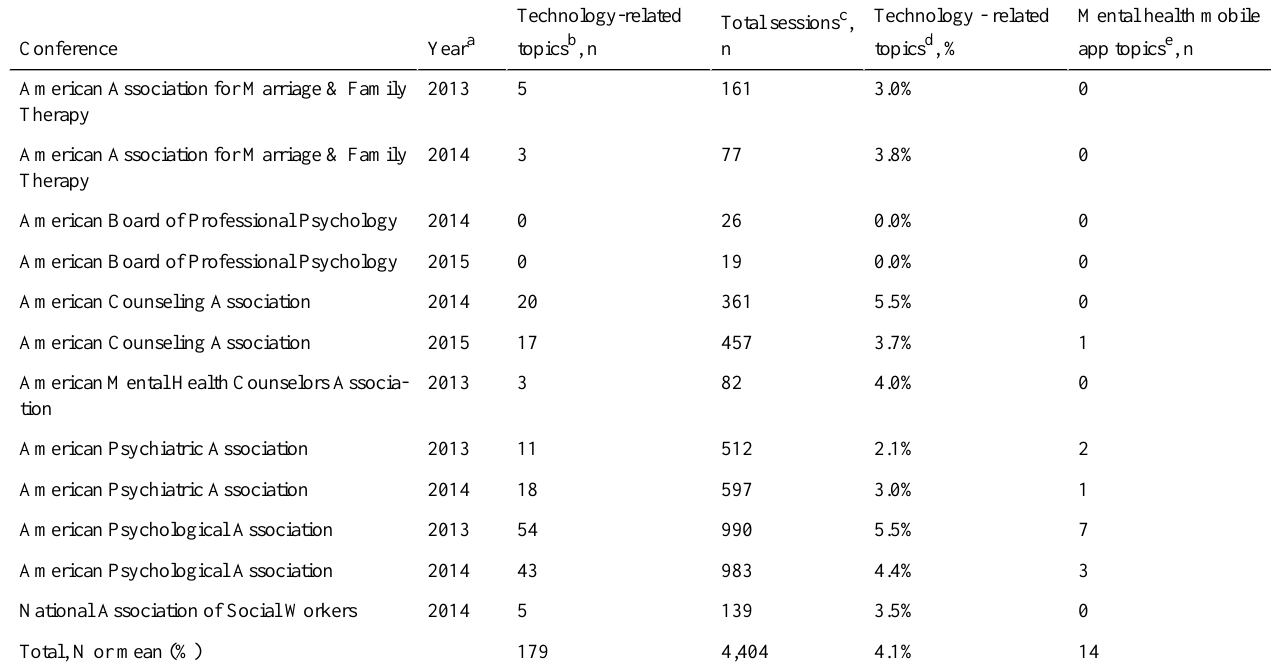
Table 1. Content analysis of mental health professional conferences 2013-2015: technology-related session